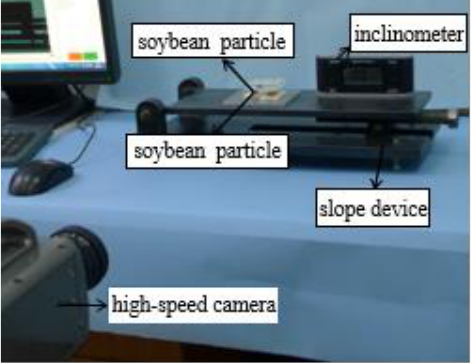
Figure 7. Static friction coefficient between soybean seed particles measured by the slope method.